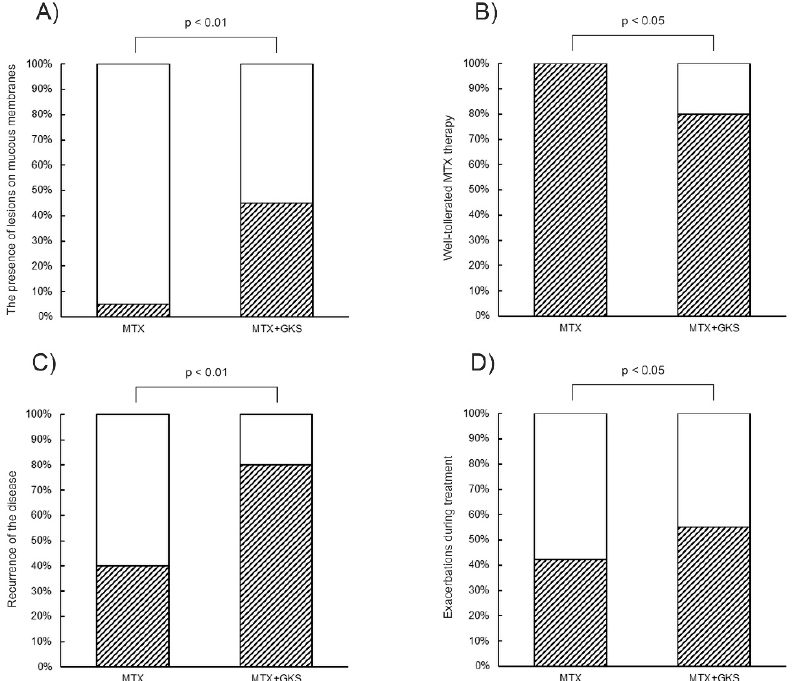
Figure 1. Comparison of Group 1 and Group 2 with regard to ( A ) age, ( B ) survival rate, ( C ) clinical remission, ( D ) minimal dose. MTX—Methotrexate, GKS—glucocorticosteroids. ( A ) and ( D ) White bar—group 1, shadow bar—group 2. The results of semiquantitative analysis are expressed as the mean ± standard deviation. The level of significance is defined where p < 0.05. ( B , C ) White and shadow bar—presented feature in the group in %.